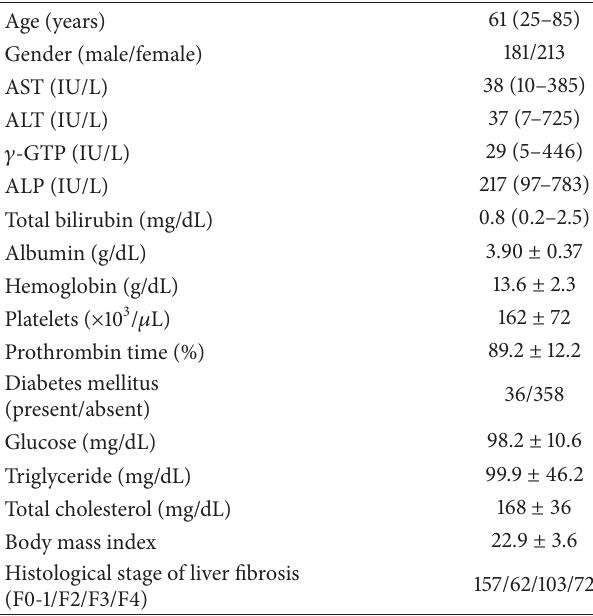
Table1:Characteristicsofthe394hepatitisCvirus-(HCV-)positive